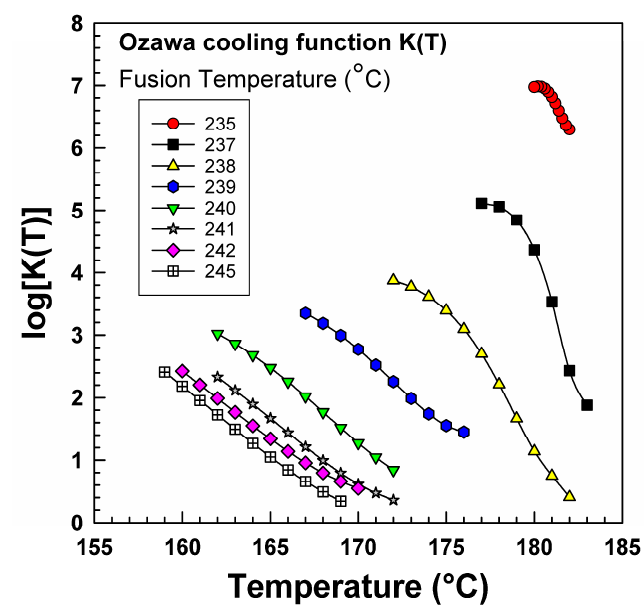
Figure 9. Ozawa cooling function.